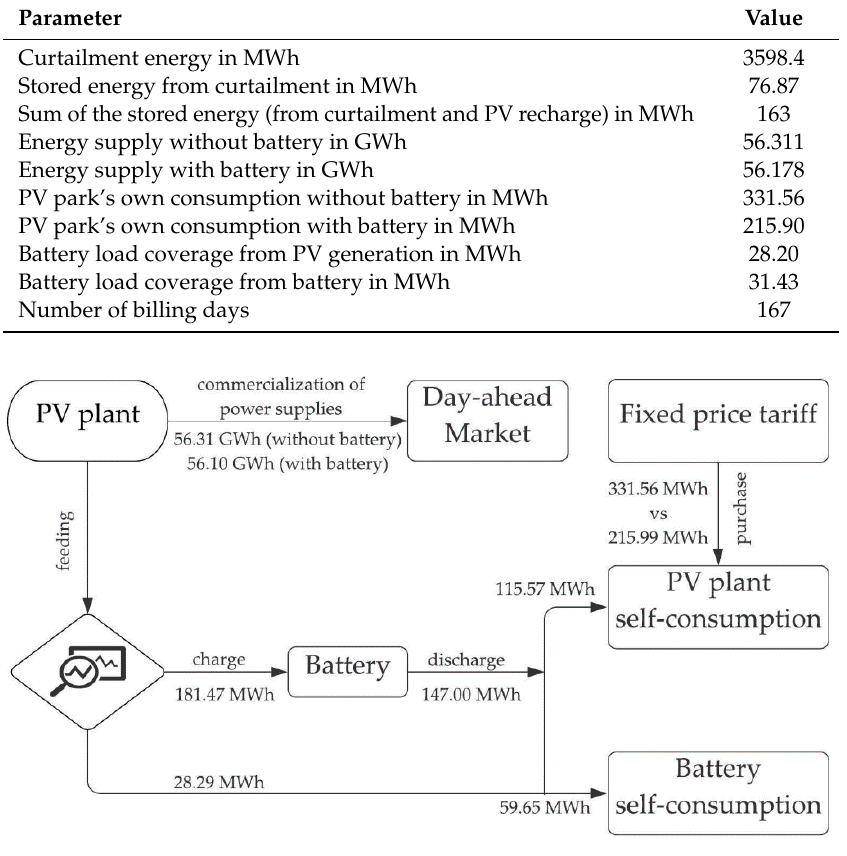
Figure 7. Diagram of energy distribution in the power grid.